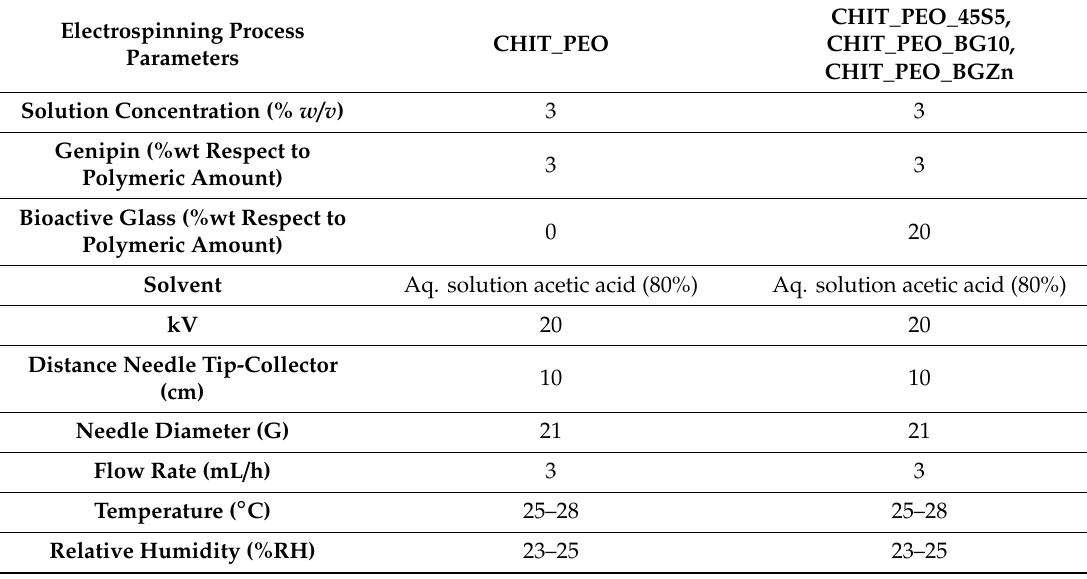
Table 2. Electrospinning